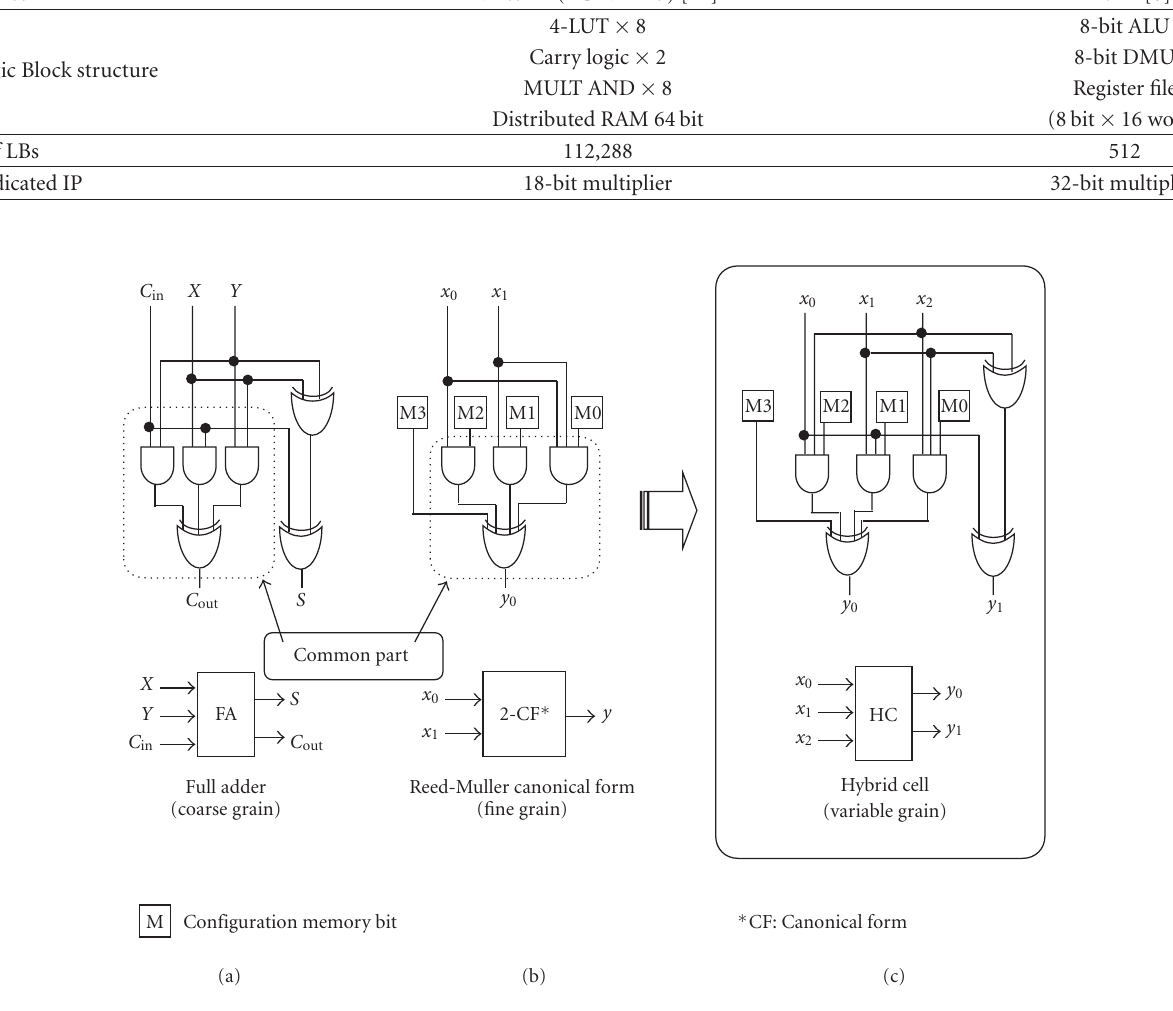
Figure 3: Basic structure of a hybrid